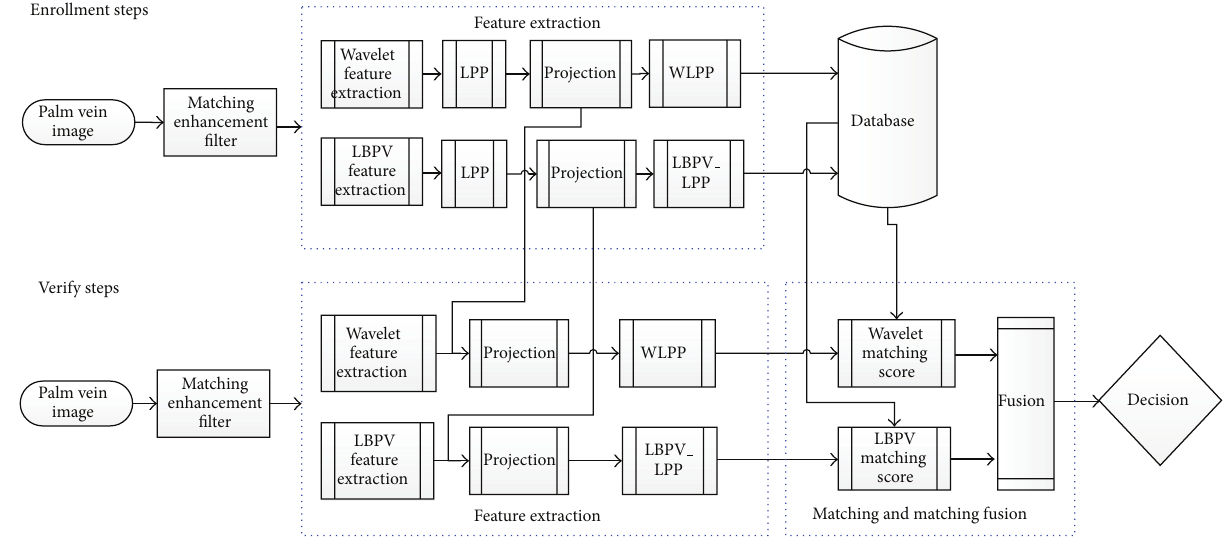
Figure 1: System